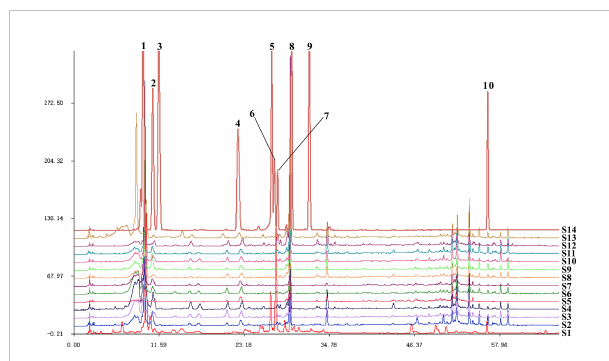
FIGURE 1 The fi ngerprints of mulberry branch extracts from 12 planting areas. S1, Mulberry leaf; S2, Heilongjiang; S3, Liaoning; S4, Hebei; S5, Shanxi; S6, Henan; S7, Jiangsu; S8, Anhui; S9, Zhejiang; S10, Sichuan; S11, Yunnan; S12, Guangxi; S13, Guangdong; S14, Mixed standard. 1, mulberroside A; 2, chlorogenic acid; 3, cryptochlorogenic acid; 4, scopoletin; 5, rutin; 6, isoquercitrin and hyperoside; 7, astragalin; 8, quercitrin; 9, resveratrol; 10,